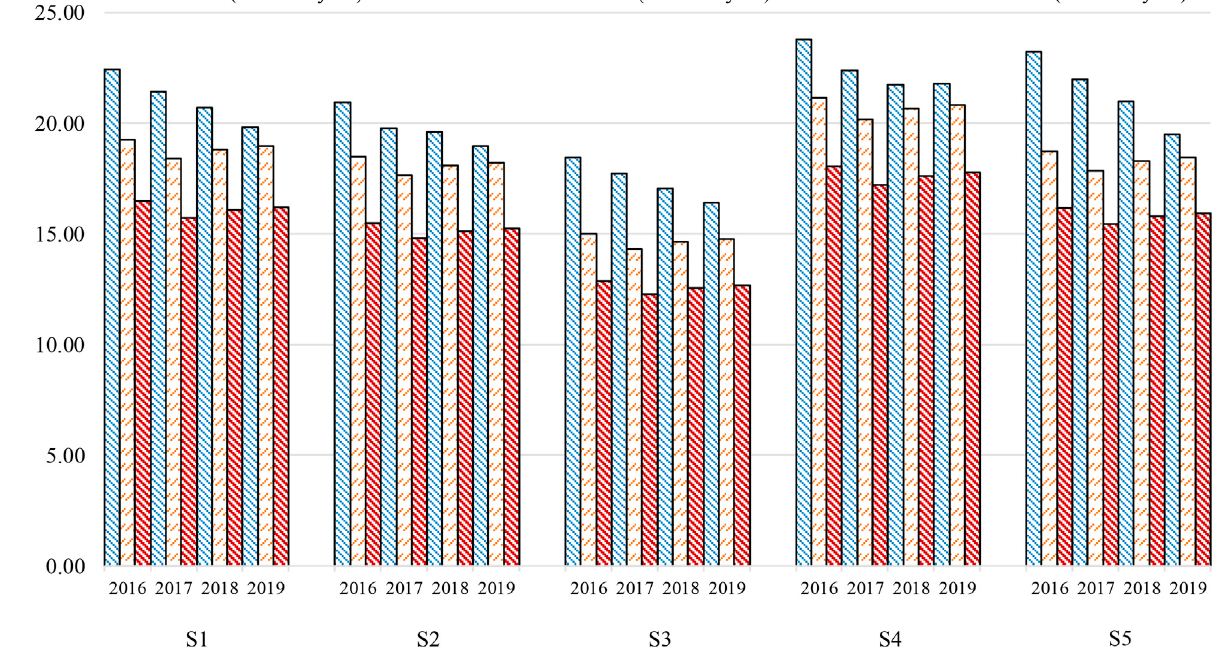
Frontiers in Built Environment |